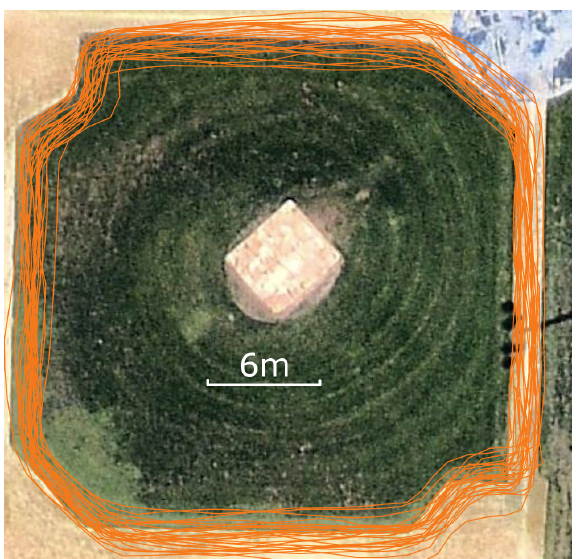
Figure 12. Results from Experiment 3 with 26 labs of uncorrected path showing a larger error in the longitude.